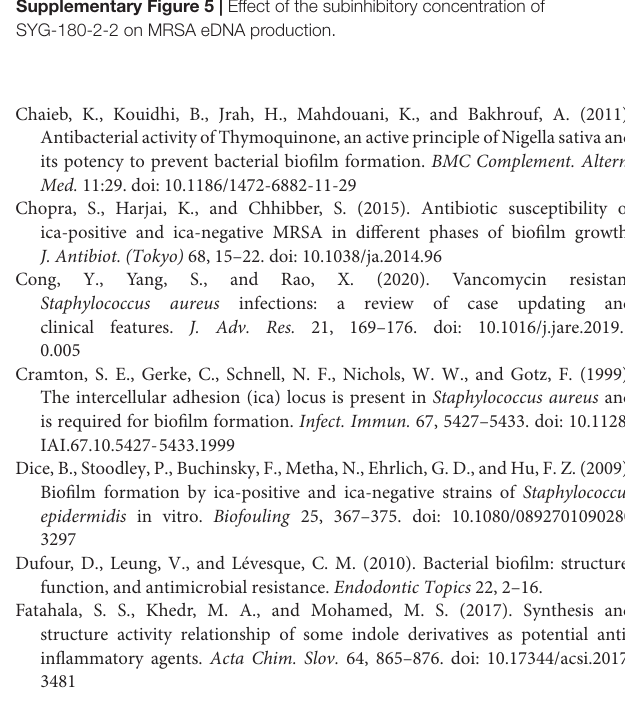
Supplementary Figure 1 | Synthetic process of SYG-180-7. 1: N -pivaloyl indoles. 2: N -(1-pivaloyl-1 H -indol-7-yl) benzamide. SYG-180-7: desired product. Supplementary Figure 2 | Nuclear magnetic resonance (NMR) identification of SYG-180-7. Supplementary Figure 3 | High-resolution mass spectrometry (HRMS) identification of SYG-180-7. Supplementary Figure 4 | Growth curves of MRSA strains cultured with SYG-180-2-2 (8 µ g/ml). Supplementary Figure 5 | Effect of the subinhibitory concentration of SYG-180-2-2 on MRSA eDNA